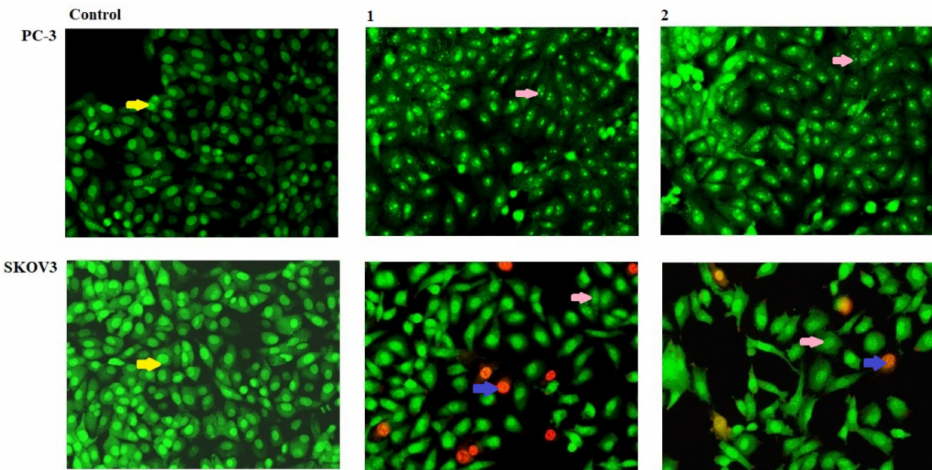
Figure 3. Morphological and nuclear changes using AO/EtBr staining that were evaluated by the effect of treatment with compounds 1 and 2 on apoptosis of PC-3 and SKOV3 human tumor cells after 48 h. The treatment-induced various nuclear changes (chromatin fragmented and condensation, nuclei condensation at 200 × ) in early and late apoptotic phases of the human tumor cells treated with compounds 1 and 2 respectively. Yellow arrows indicate live cells (cells with normal green nuclei). Pink arrows indicate early apoptotic cells (bright green nuclei with fragmented chromatin). Blue arrows indicate late apoptotic cells (orange-stained nuclei with chromatin condensation or fragmentation).